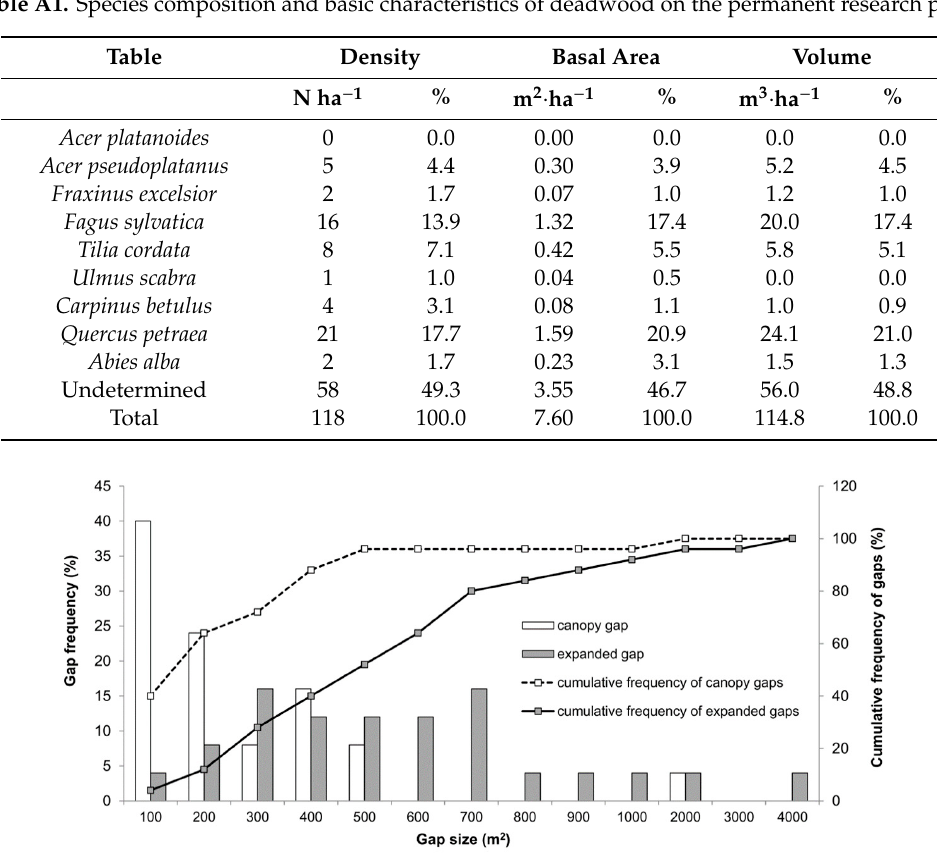
Figure A1. Frequency of canopy gaps (light bars) and expanded gap (dark bars) according to gap size classes (calculated as number of gaps in gap size category per total number of gaps).